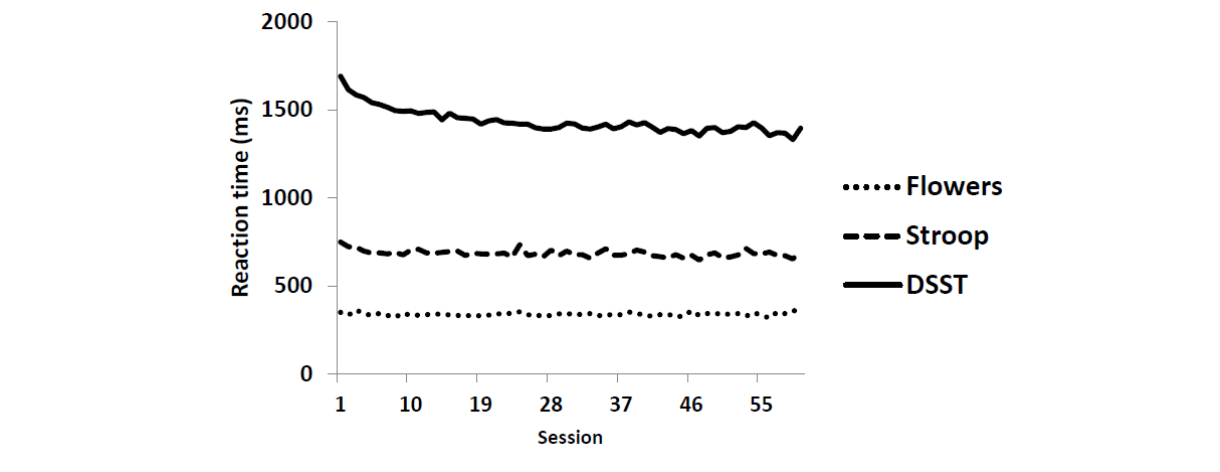
Figure 2. Average reaction time across sessions: flowers, marijuana Stroop, and digit symbol substitution task tasks. DSST: digit symbol substitution task.